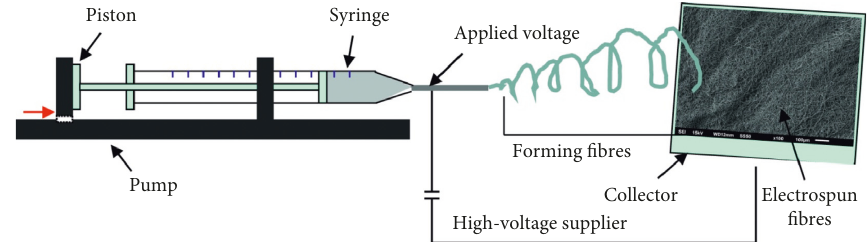
Figure 9: Schematic representation of conventional electrospinning setup to prepare electrospun nanofibres (archive of